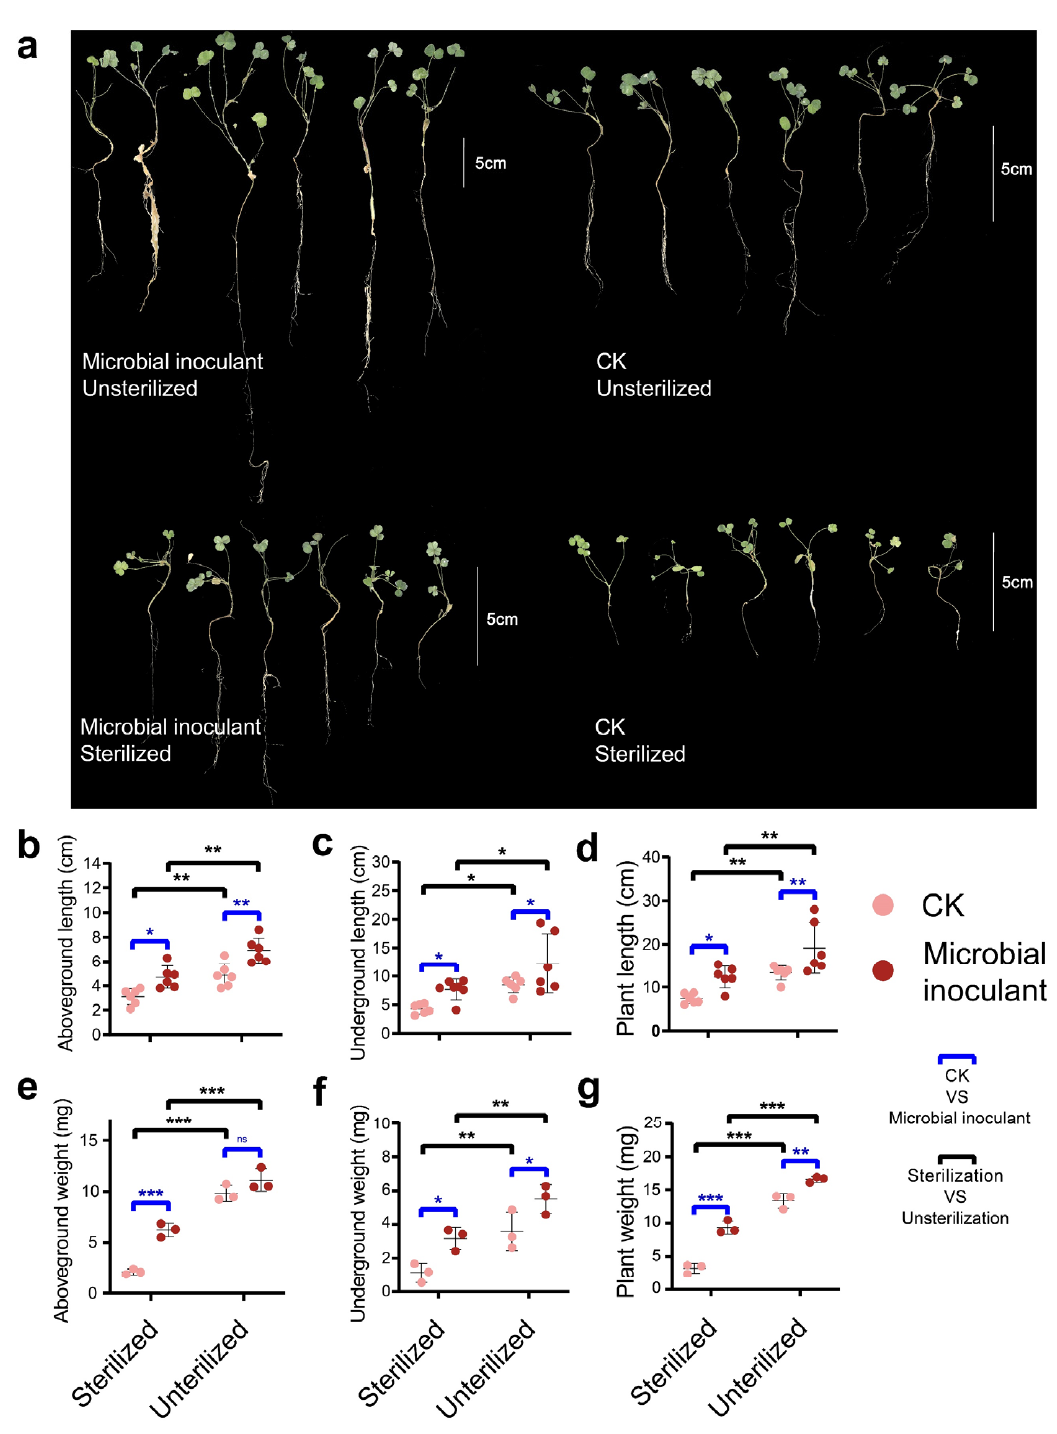
Figure 1. ( a ) Plant growth under different treatments. ( b ) aboveground length. ( c ) underground length. ( d ) plant length. ( e ) aboveground dry weight. ( f ) underground dry weight. ( g ) plant weight. Note: ns indicates no significant effect, * indicates p < 0.05, ** indicates p < 0.01, and *** indicates p < 0.001.